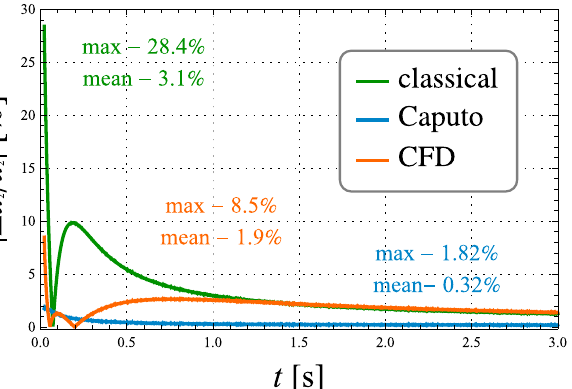
Figure 5. Relative error of the time-voltage characteristics of the ladder element depending on the model for α 1 = 0.60.